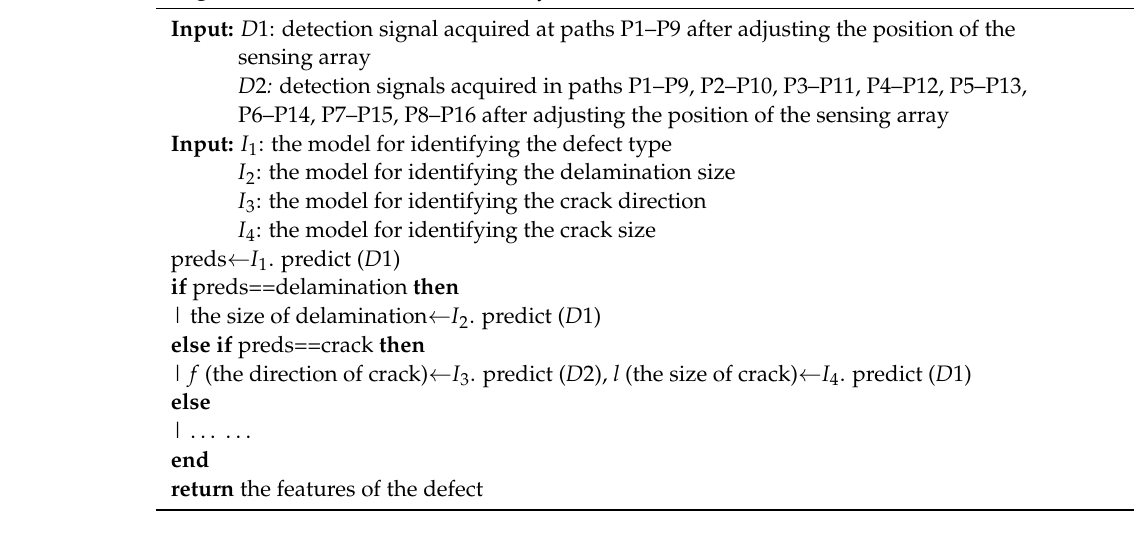
Algorithm 3: Precise imaging of